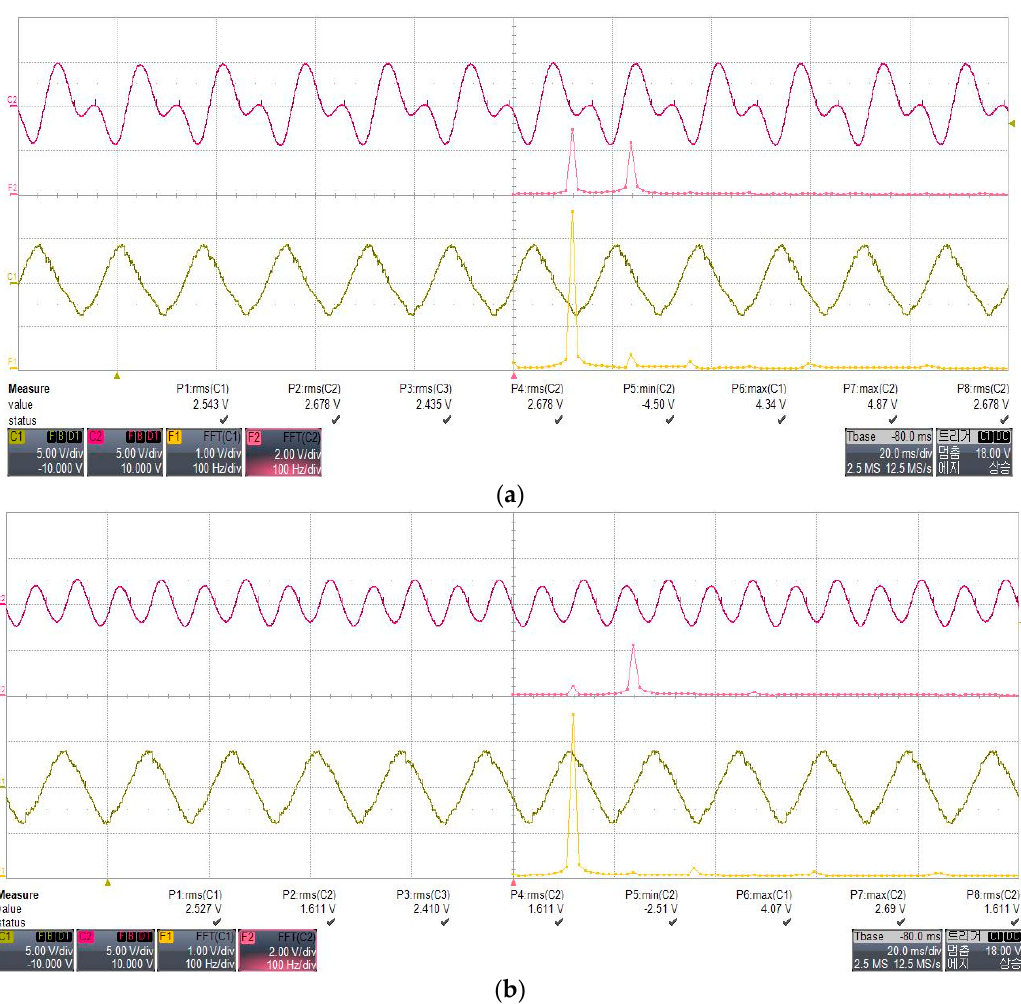
Figure 11. Experimental results of DC-link voltage and phase current of ( a ) without and ( b ) with applying the proposed DC offset error compensation algorithm.